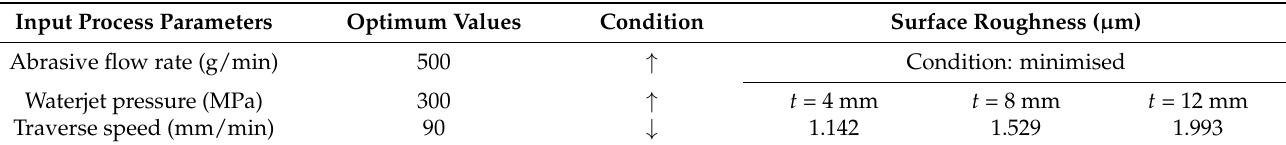
Table 9. Optimum parameters for surface